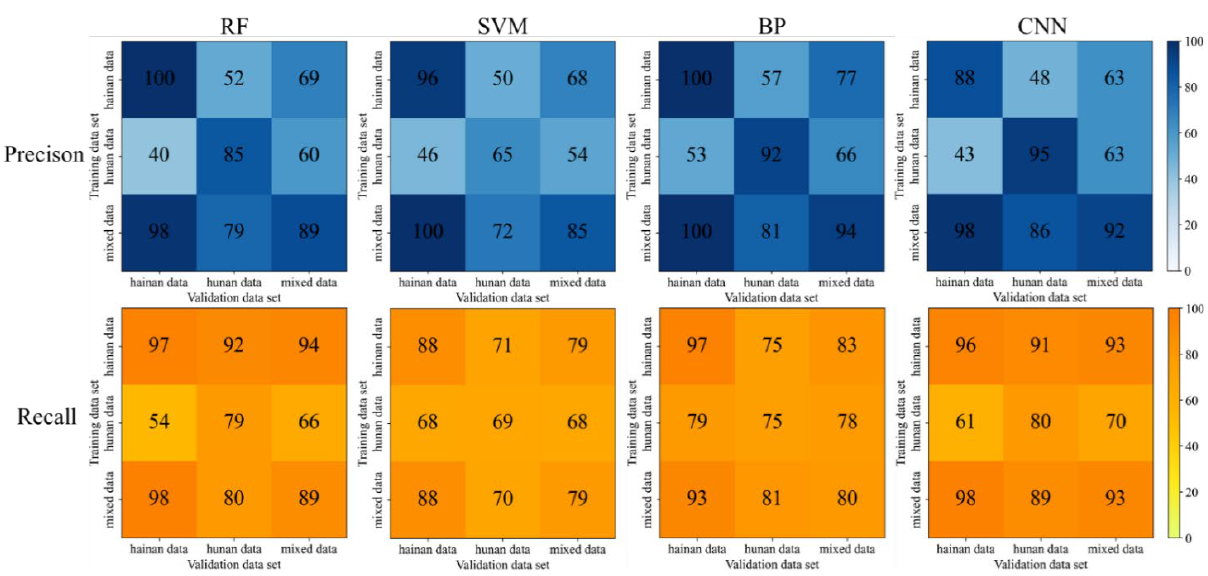
Figure 10. Evaluation results of each algorithm after feature selection with GA algorithm.